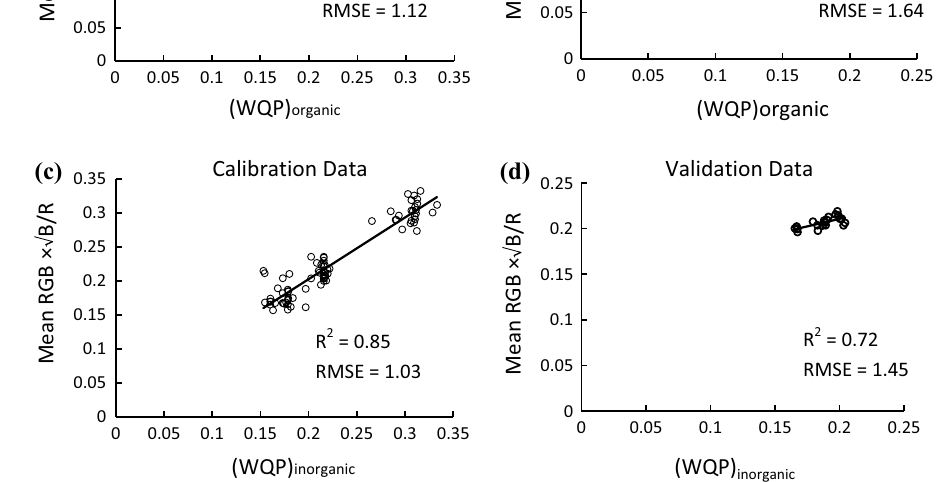
Fig. 3 Scatter plots of B ∕ R RGB ) × � with WQP � ( √ classes a calibration data (WQP) organic b validation data (WQP) organic c calibration data (WQP) inorganic d validation data (WQP)